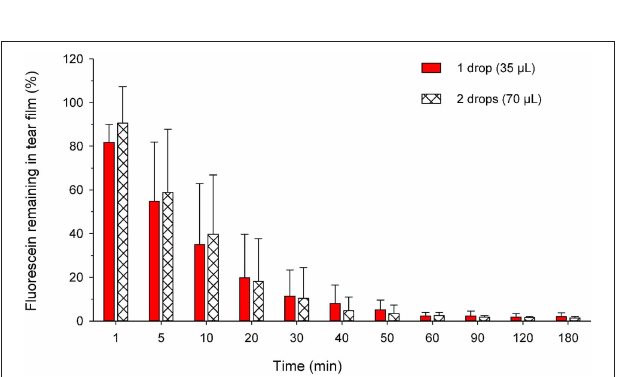
FIGURE 8 | Bar chart depicting the mean + SD of residual tear film fluorescence at each time point in canine eyes receiving either one drop (35 µ l; plain red bars) or two drops (70 µ l; hatched white bars) of 1% fluorescein solution. For standardization, the residual fluorescence in both groups was compared to the tear fluorescence obtained at t = 0min in eyes receiving a single drop of fluorescein. No statistical differences were noted between both groups at any time point ( P ≥